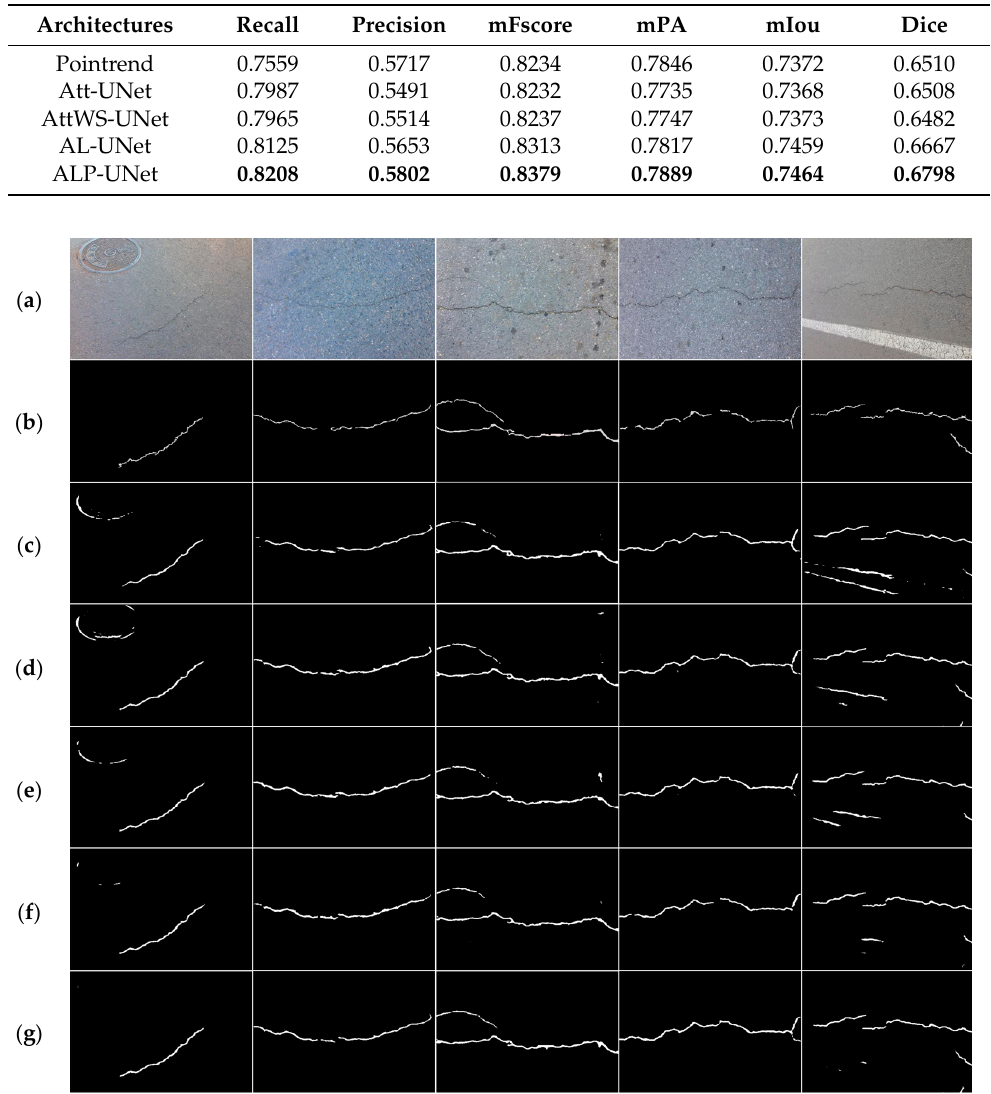
Figure 4. Results of the pavement segmentation dataset with different modules added. ( a ): input color images; ( b ): ground truth; ( c ): results of the Pointrend; ( d ): results of the Att-UNet; ( e ): results of the AttWS-UNet; ( f ): results of the AL-UNet; ( g ): results of the ALP-UNet.